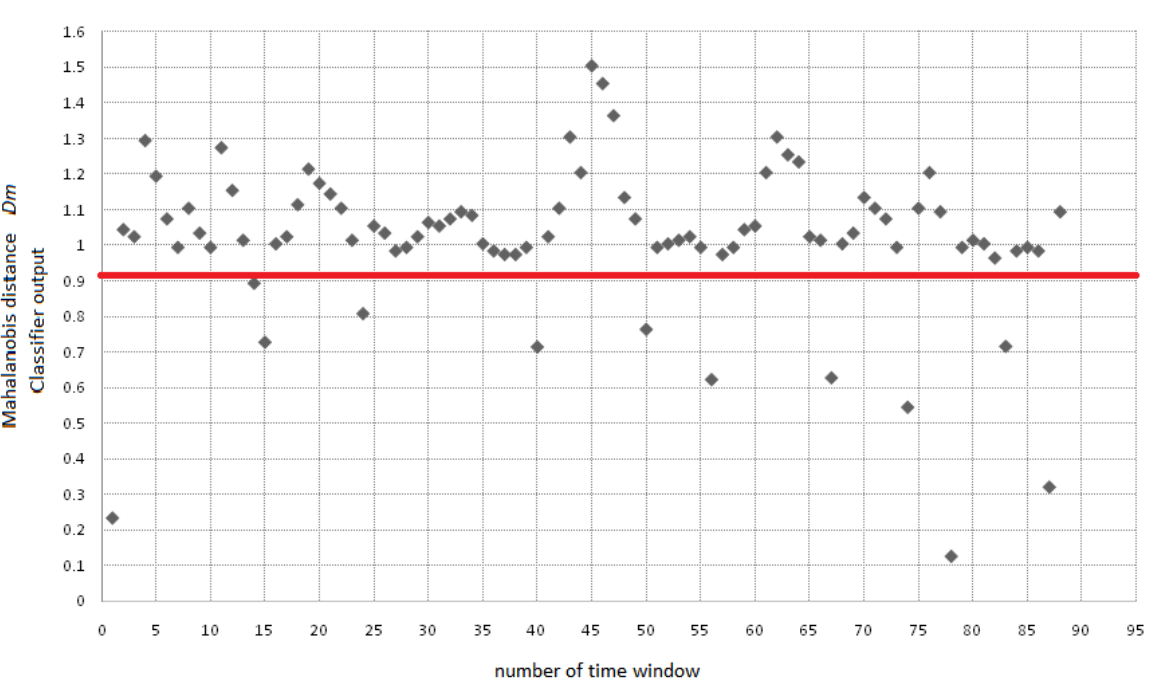
Figure 17. Range of double blink detection for the classification